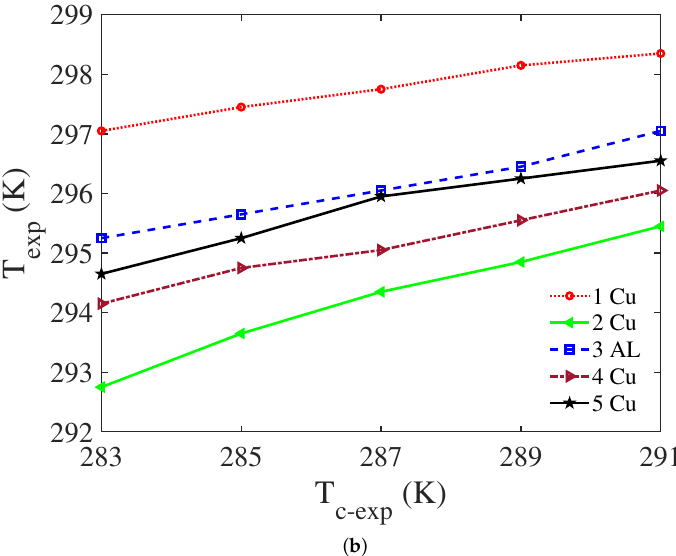
Figure 13. Variations of outlet temperature: ( a ) simulation results of outlet temperature as a function of t f for different N (the cold-side temperature of the TEM is fixed to 12 ◦ C); ( b ) experiment results of outlet temperature for different cold-side temperatures of the